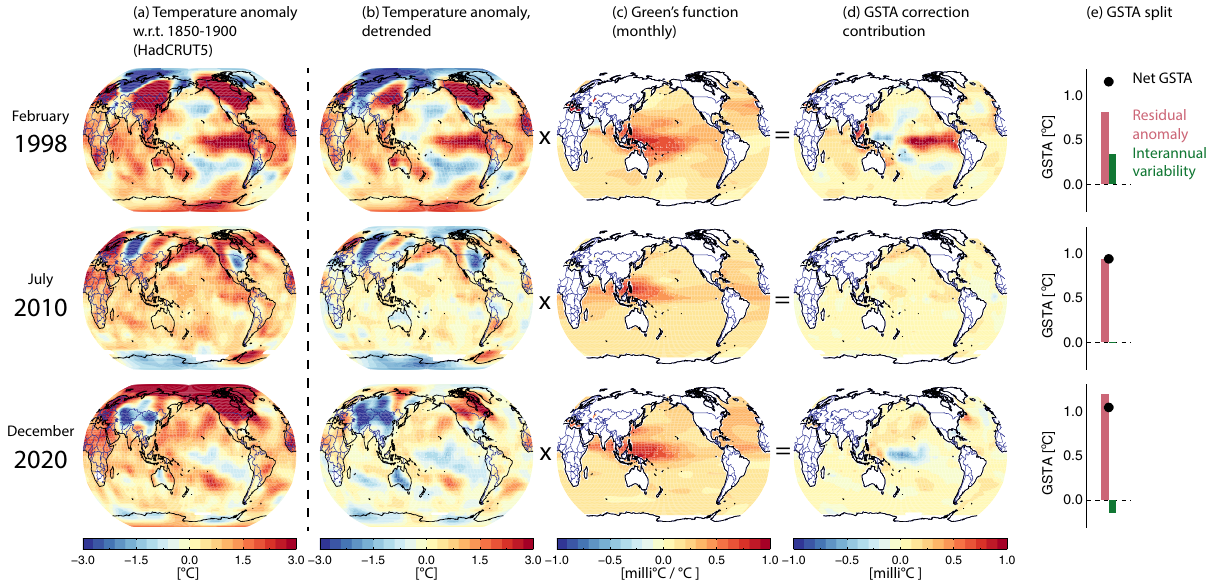
Fig. 1 Calculation of modulations on global surface temperature anomaly (GSTA) from the pattern of sea surface temperatures (SST), for 3 example months. a Raw temperature anomaly from HadCRUT5, relative to 1850 – 1900 mean for that month. b Detrended temperature anomaly. c Green ’ s Function (GF) for the corresponding month, derived from the CESM1 global climate model, shows the contribution of an SST anomaly in a given grid cell to the GSTA anomaly. d GSTA modulation, found by multiplying the GF with the detrended anomaly map. e Net global surface temperature anomaly for that month, and its split into a variability (SST modulation) and a residual component. The variability (green bar) is equal to the sum of the map in column ( d ). The three months illustrate (top) strong El Nino conditions, (middle) neutral conditions, and (bottom) moderate La Nina same year, and (as for panel a) show the residual standard deviation (RSD) of the 10-year fi ltered and un fi ltered warming